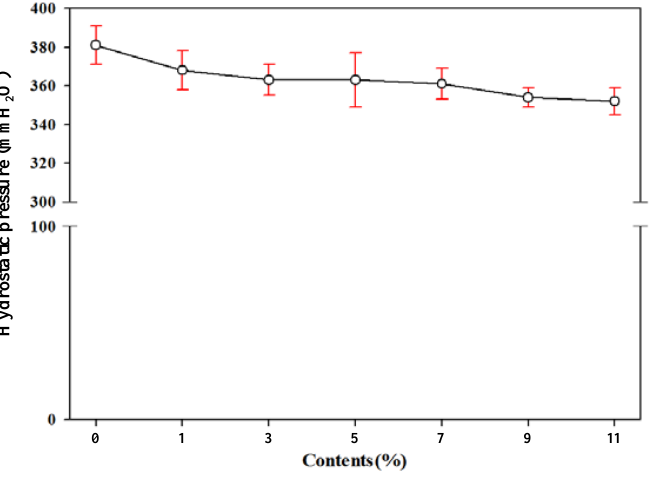
Figure 9. Hydrostatic pressure by low pressure tester of polyester thermoplastic film with various contents of thermally expandable microcapsules.